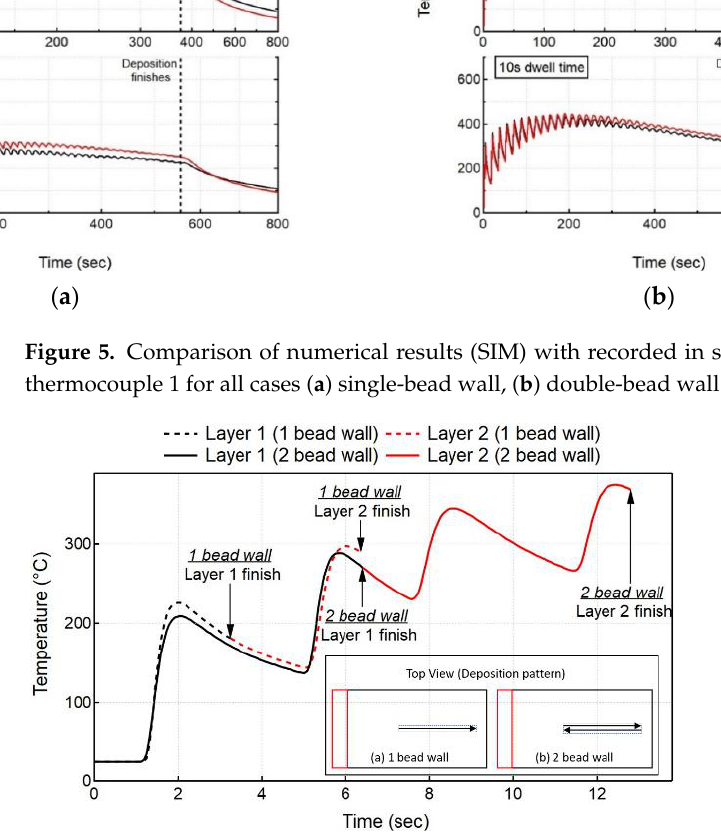
Figure 6. Comparison of temperature evolution between single- and double-bead wall at TC1 location during the deposition of the first two layers.